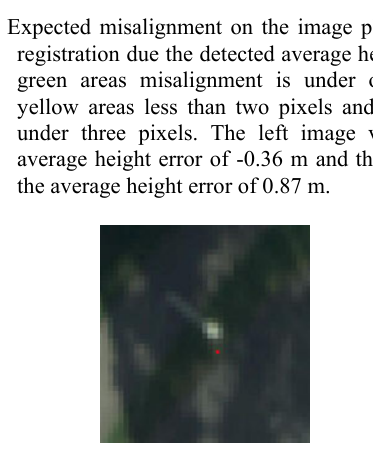
Figure 8. A detail of the misalignment close to the edge of the image after the relative orientation using NTFs. In this case, laser observation (red dot) should hit to the top of a street lamp (white area). The majority of misalignment is caused by the orientation error along the direction of Z coordinate. The direction of the misalignment on the image plane is towards the nadir point of the